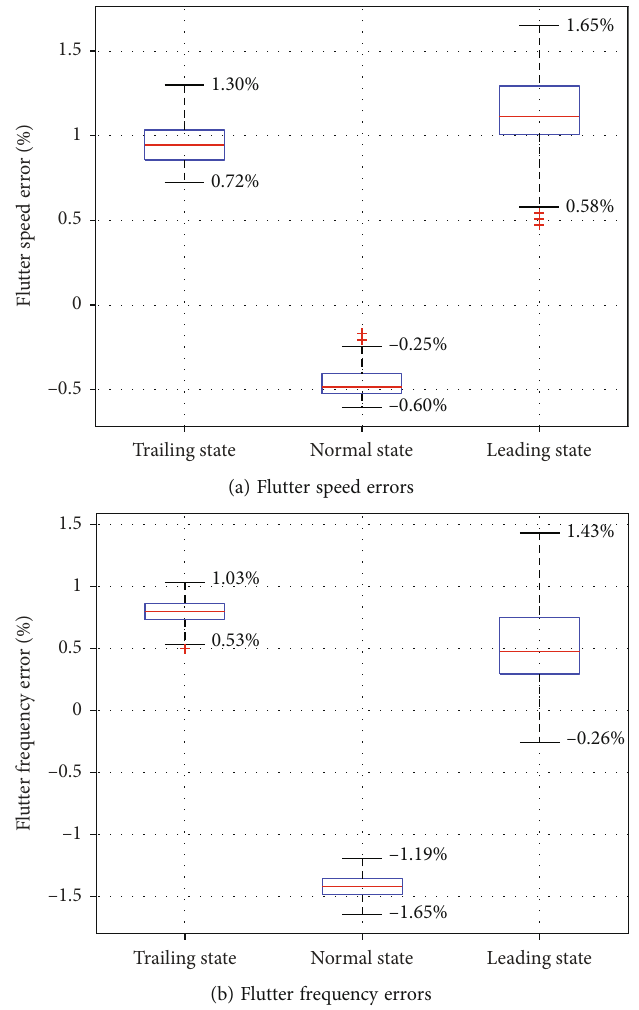
Figure 15: Box diagrams of GFBP errors at Ma = 0 : 2